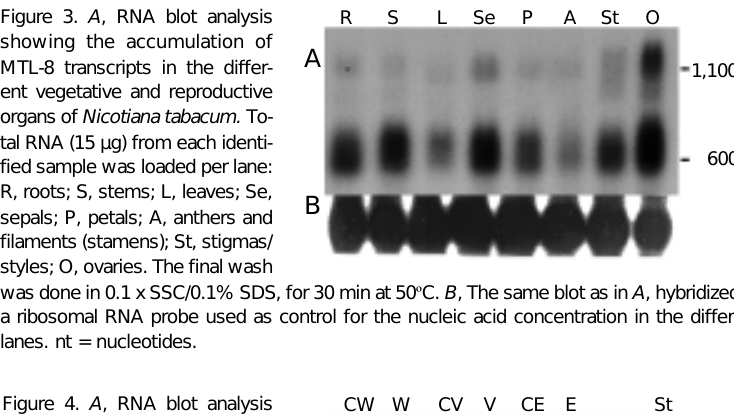
Figure 4. A , RNA blot analysis showing the accumulation of MTL-8 transcripts in leaves from Nicotiana tabacum plants sub- mitted to different stress condi- tions. Total RNA (15 µg) from each identified sample was loaded per lane: CW, control of